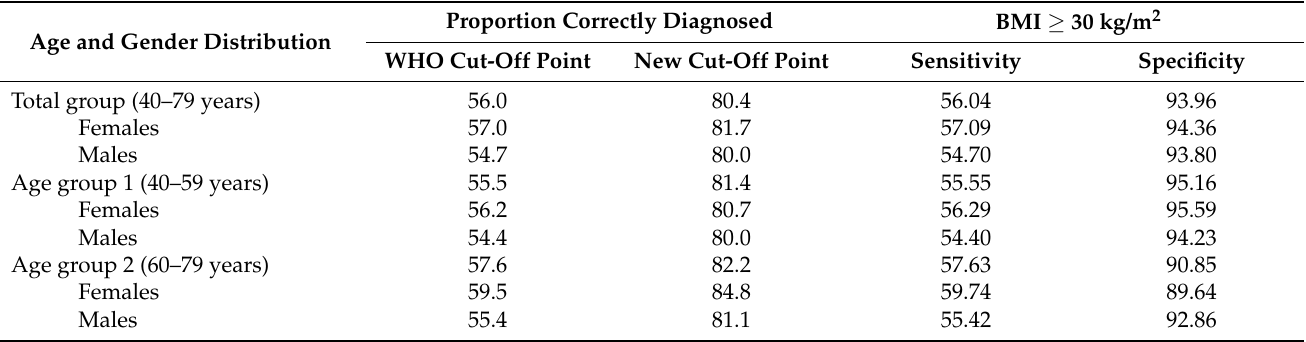
Table 3. Proportion correctly diagnosed by WHO cut-off points and new cut-off points and the sensitivity and specificity at BMI ≥ 30 kg/m 2